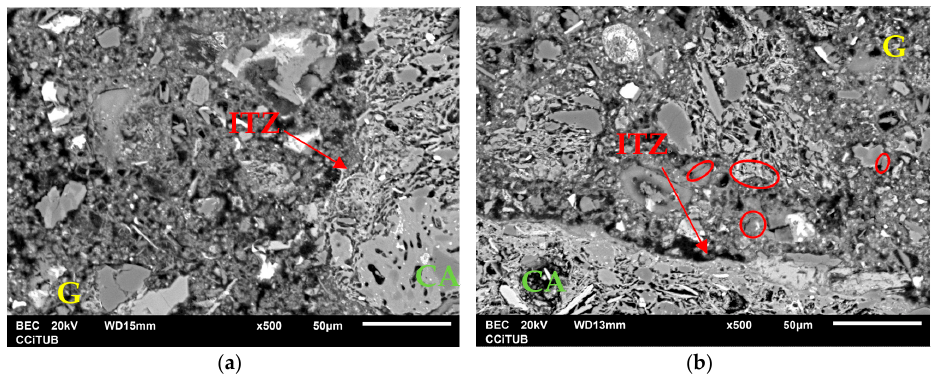
Figure 7. SEM of: ( a ) RCM50 (50% of CA); and ( b ) RCM100 (100% of CA).